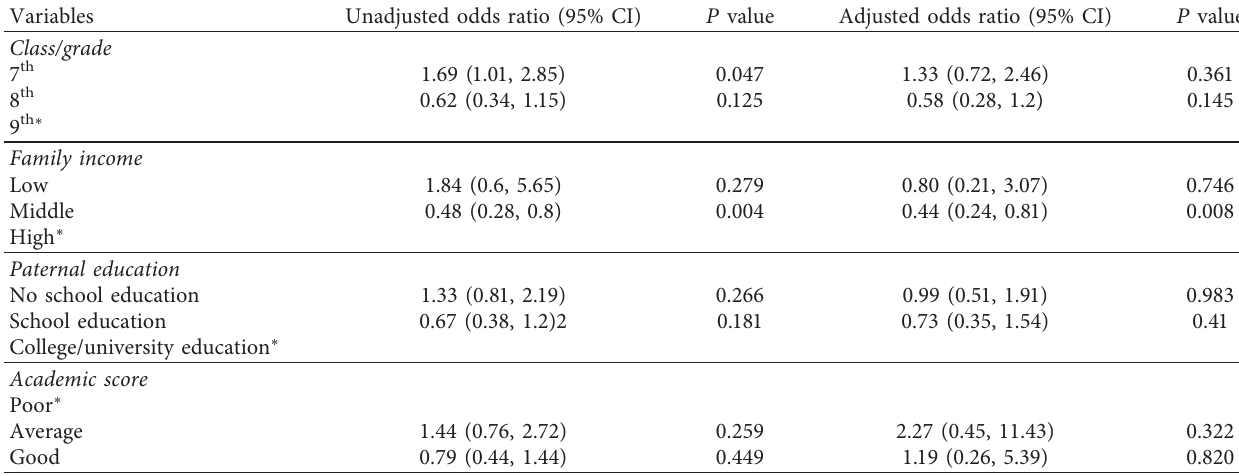
Table 2: Association between sociodemographic factors and dental trauma.